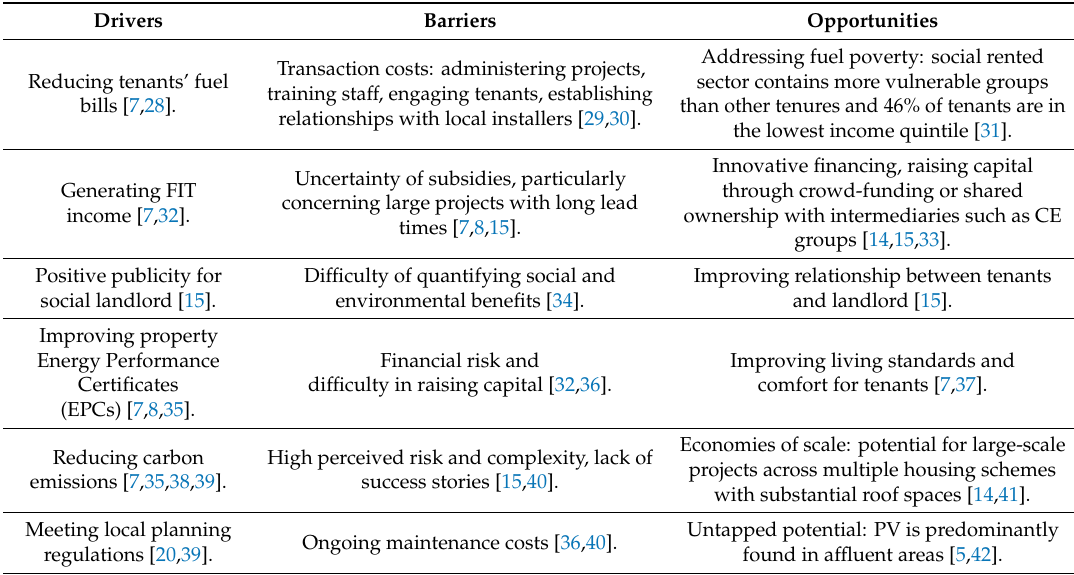
Table 1. Common drivers, barriers and opportunities for the uptake of solar PV by social landlords. Drivers Barriers Opportunities Reducing tenants’ fuel bills